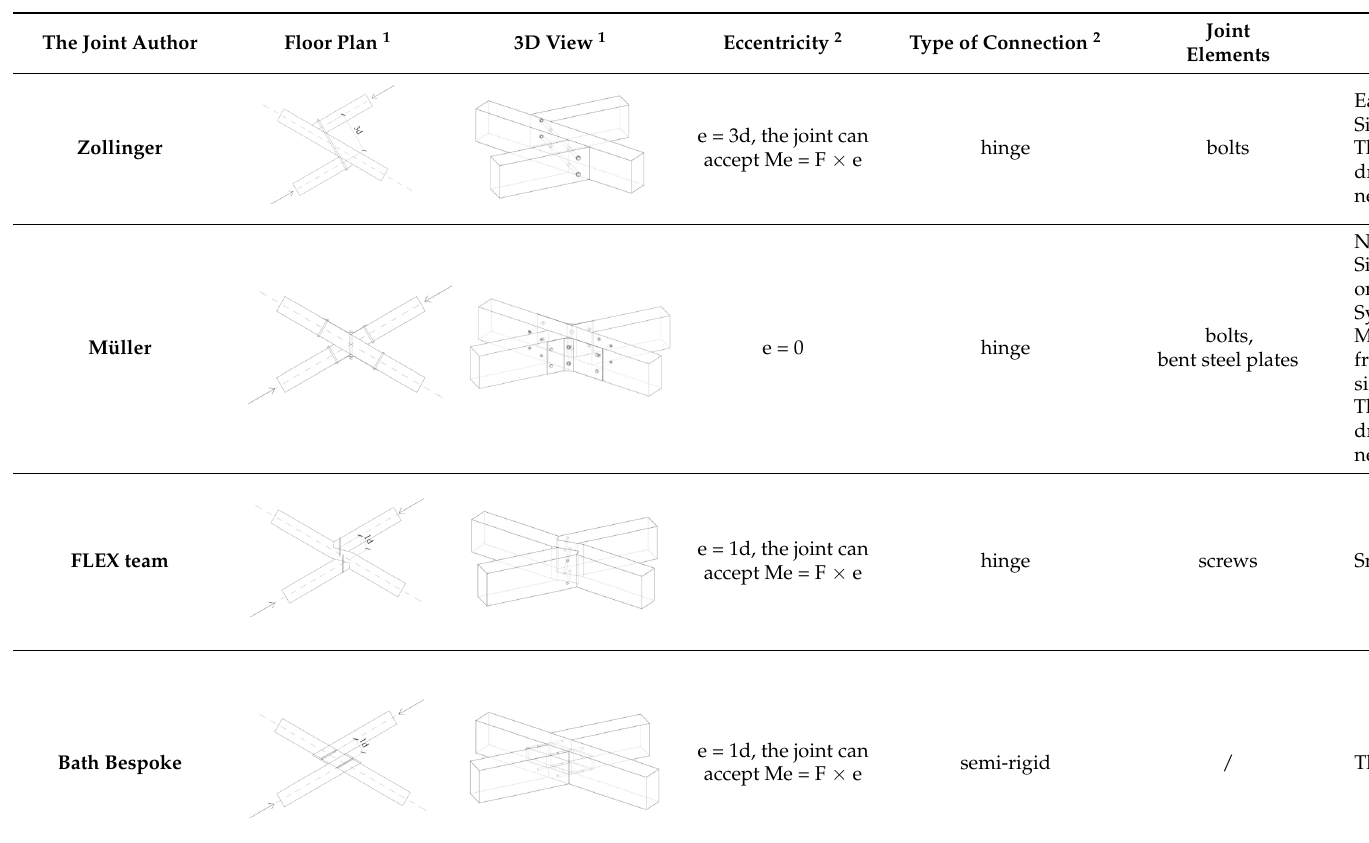
Table 1. Systematization of the Existing Timber Lamellae Joints.